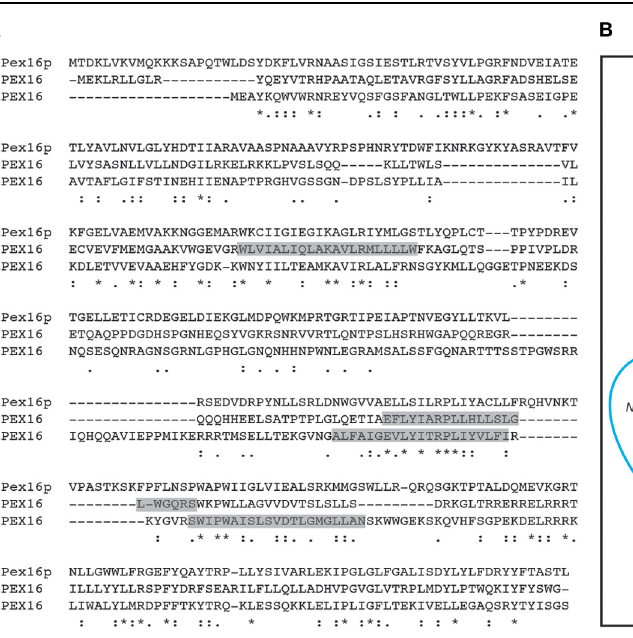
FIGURE 2 | Polypeptide sequence alignment and phylogenetic analysis of various PEX16 proteins. (A) Deduced amino acid sequence alignment of Y. lipolytica Pex16p (YlPex16p), human ( Homo sapiens ) PEX16 (HsPEX16), and A. thaliana PEX16 (AtPEX16). Identical residues are indicated with asterisks, strongly and weakly similar residues are indicated with a colons and periods, respectively. Predicted membrane-spanning sequences in HsPEX16 and AtPEX16 are shaded and based on Honsho et al. (2002) and Karnik and Trelease (2007), respectively. (B) Phylogenetic analysis of PEX16 sequences from selected evolutionarily diverse species. Each protein is labeled based on its respective Genus and species, and those shown in (A) are indicated